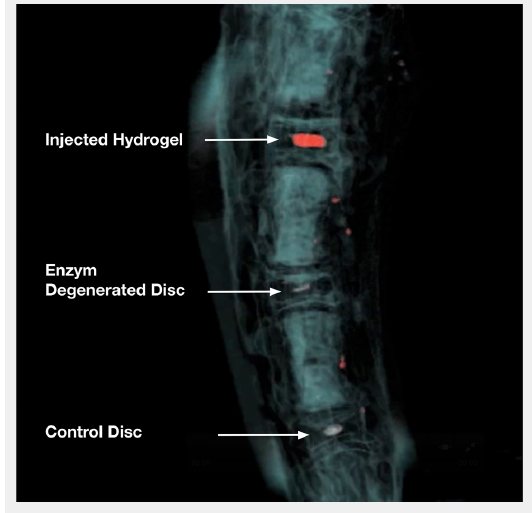
3D reconstruction of Magnetic Resonance Image (MRI) of a bovine tail intervertebral disc animal model. The upper two discs were treated with a certain dose of papain for 7 days to initiate disc degeneration. The papain enzyme was blocked with ebselen after 7 days. The NP region of the uppermost disc was then filled with a thermo-reversible p-NIPAM hydrogel (~200 µL) and imaged after ~24h on a 3 Tesla scanner